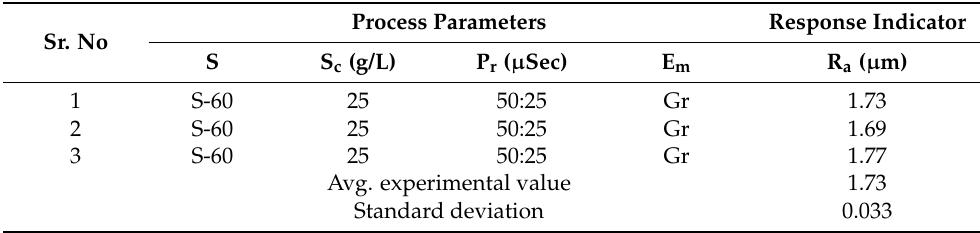
Table 6. Confirmatory experiments on the